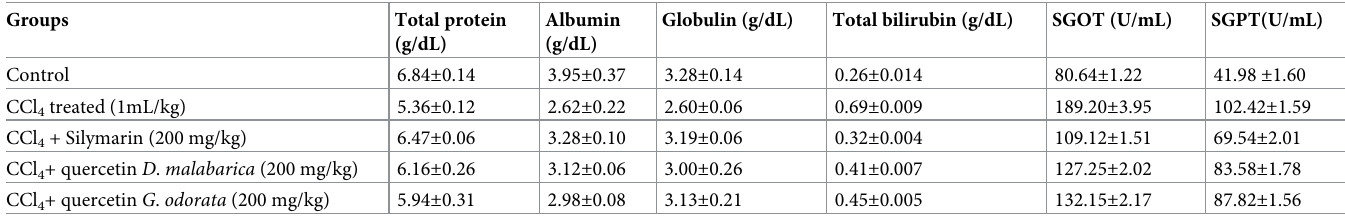
Table 2. Effects of methanolic extract from Diospyros malabarica and Gynocardia odorata on liver Total protein, Albumin, Globulin, Total bilirubin, SGOT and SGPT on CCl 4 induced hepatotoxicity in rats.